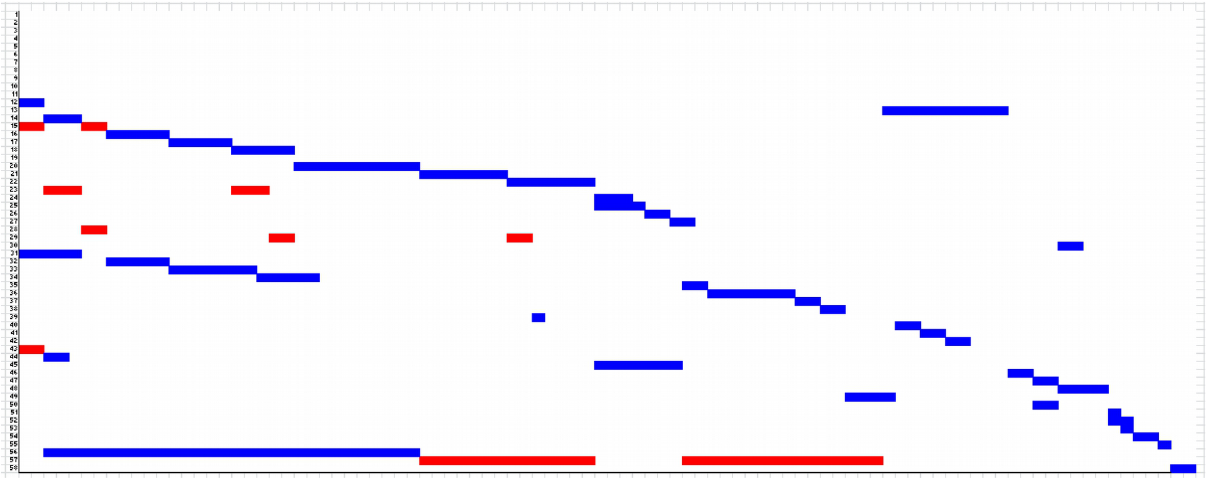
Figure 65. The modified Gantt chart for the